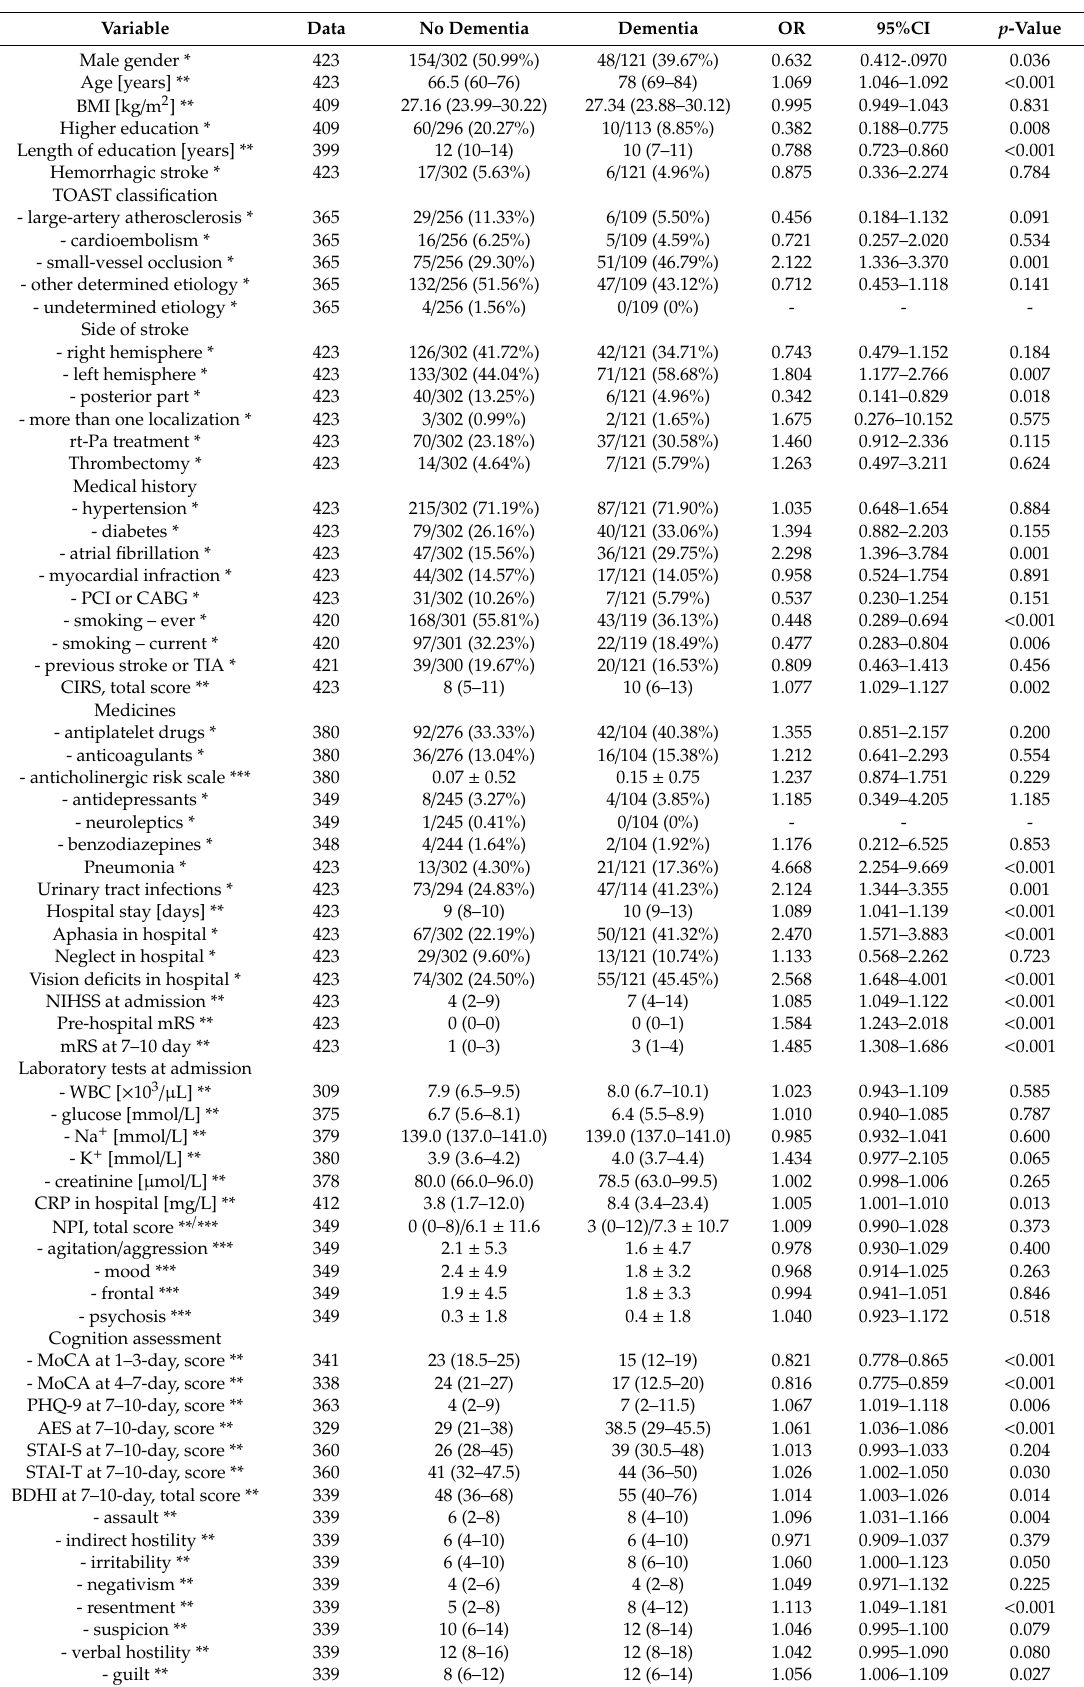
Table 2. Predictors of post-stroke dementia at the three-month follow-up in the univariate logistic regression